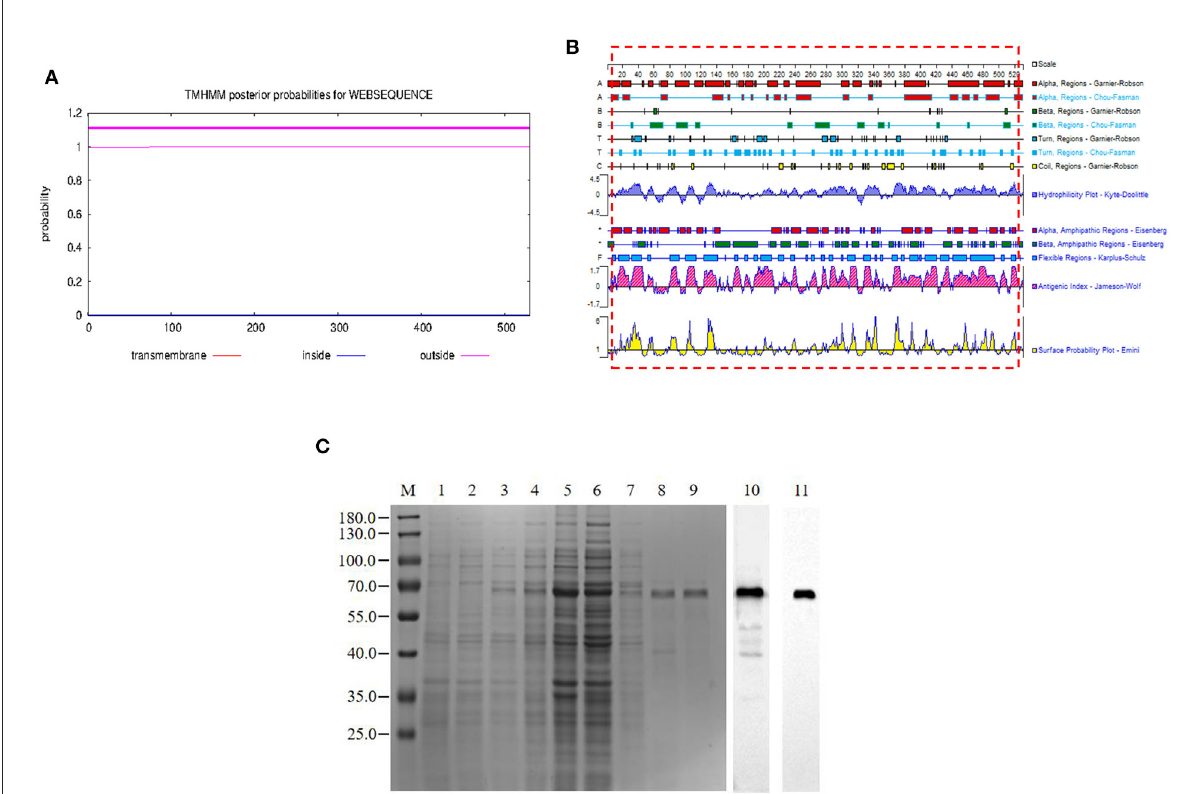
FIGURE1 Expression and purification of the pB602L protein. (A) Prediction of the full-length transmembrane region of pB602L protein (B) Expression of pB602L protein in vector pCold I. (C) Protein marker, 1- transformed cells of BL21/pCold after IPTG induction for 16h, 2- whole bacteria without induction, 3- BL21/pCold-B602L whole bacteria after IPTG induction for 16h, 4-BL21/pCold-B602L supernatant after induction at 16 ◦ C, 5-BL21/pCold-B602L precipitation after IPTG induction for 16h, 6-Purification of recombinant pB602L protein flow-through by Ni + spin column affinity chromatography, 7-Ni + spin column affinity chromatography purification of recombinant protein pB602L 40mM imidazole washing solution, 8, 9-purified recombinant pB602L protein by affinity chromatography of Ni + spin column, 10-Western blot analysis of p602L protein using ASFV-positive pig serum, 11-Western blot analysis of p602L protein using anti-His. A prominent band with the expected size 65 kDa appeared after